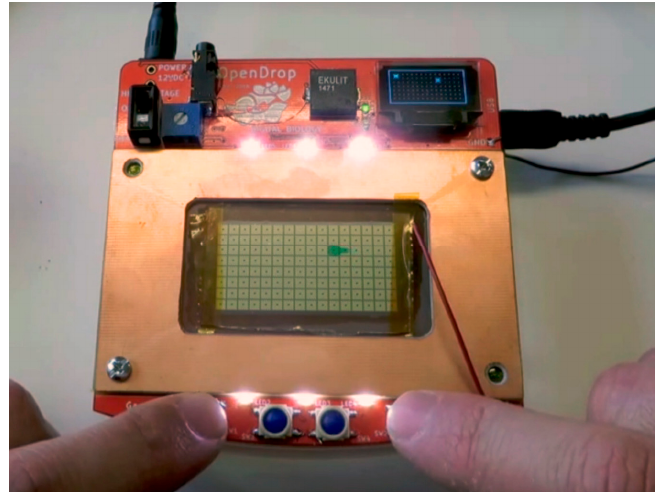
Figure 15. The front side of the next generation O PEN D ROP . The four buttons allow direct manipulation of droplets. The display on the top right side shows real-time the droplet movement.